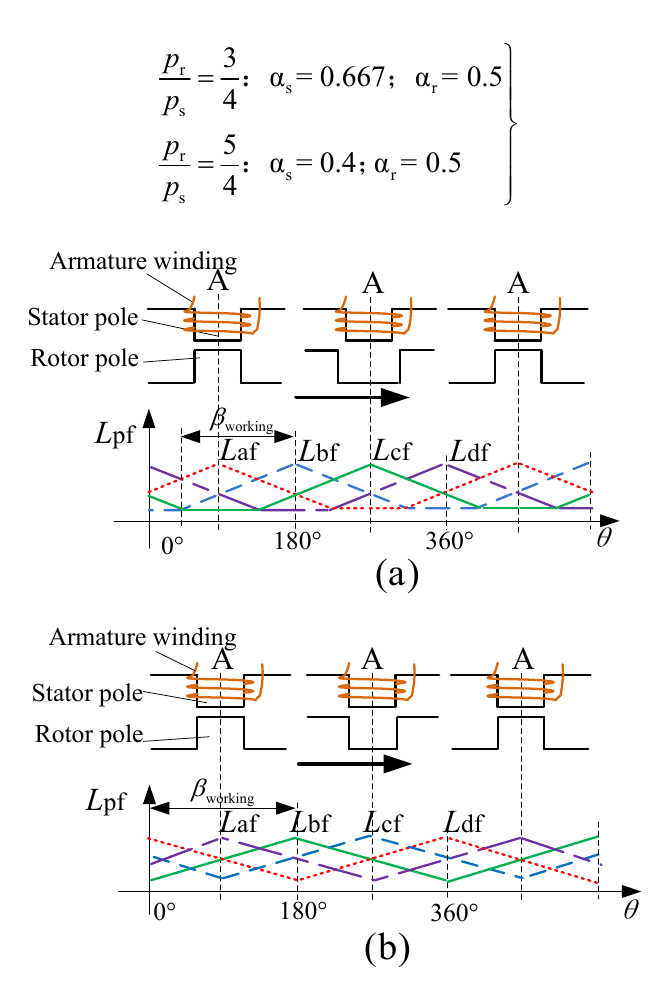
Figure 3. L pf of the four-phase WFDSM with different α r . ( a ) α s = 0.5, α r = 0.375; ( b ) α s = 0.667, α r =